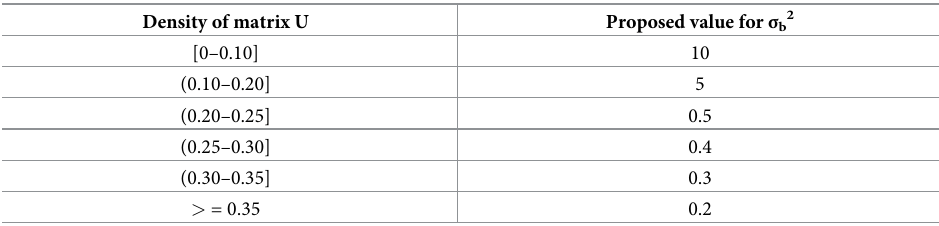
Table 3. The proposed values for the variance of the prior distribution.